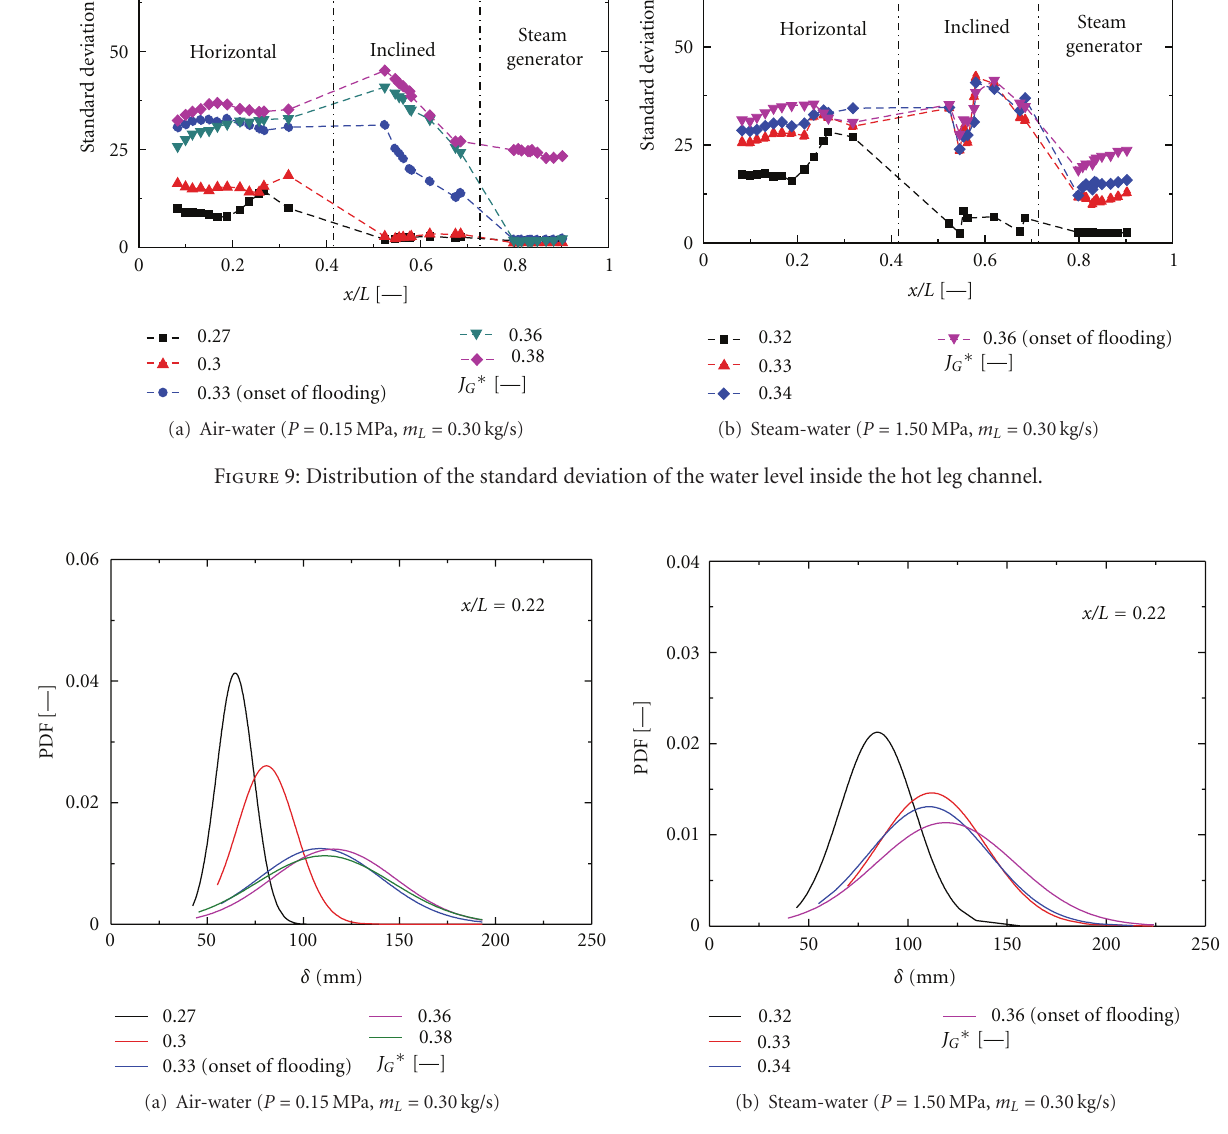
Figure 10: Probability distribution function ( x/L = 0.22, m L =